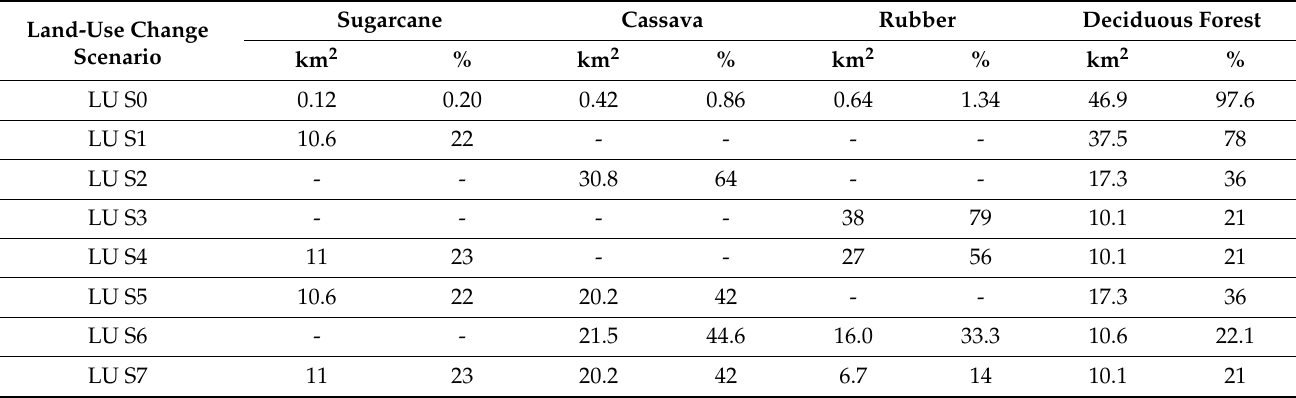
Table A1. Land area under different land-use change scenarios.